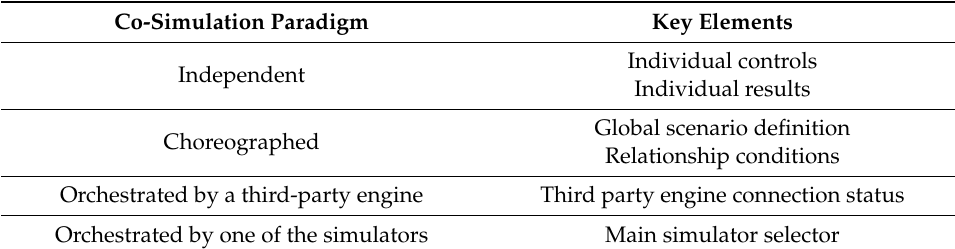
Table 10. User interface key elements.